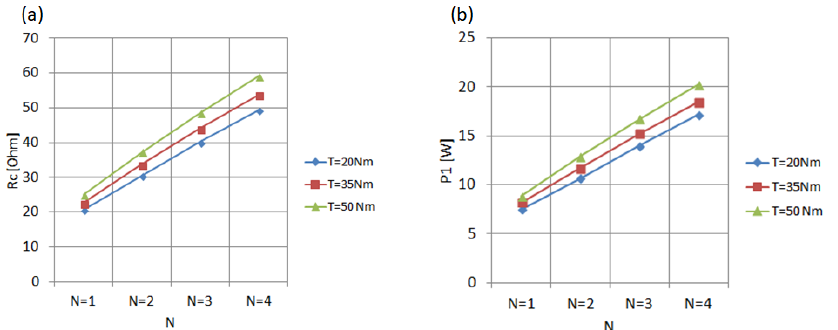
Figure 5. ( a ) Values of coil resistance R c and ( b ) electrical power consumption P el vs. number of discs